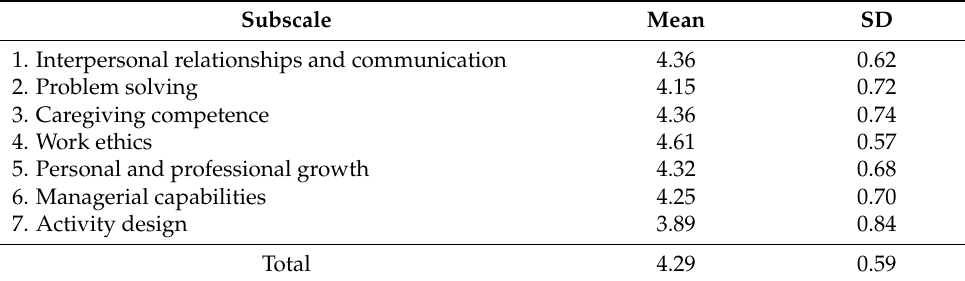
Table 4. Nurse aides’ work competence evaluated by registered nurses ( N = 102).